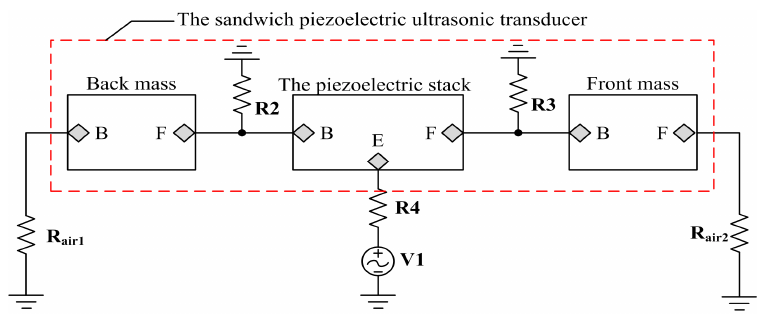
Figure 9. The AC analysis simulation circuit of the sandwiched piezoelectric ultrasonic transducer.